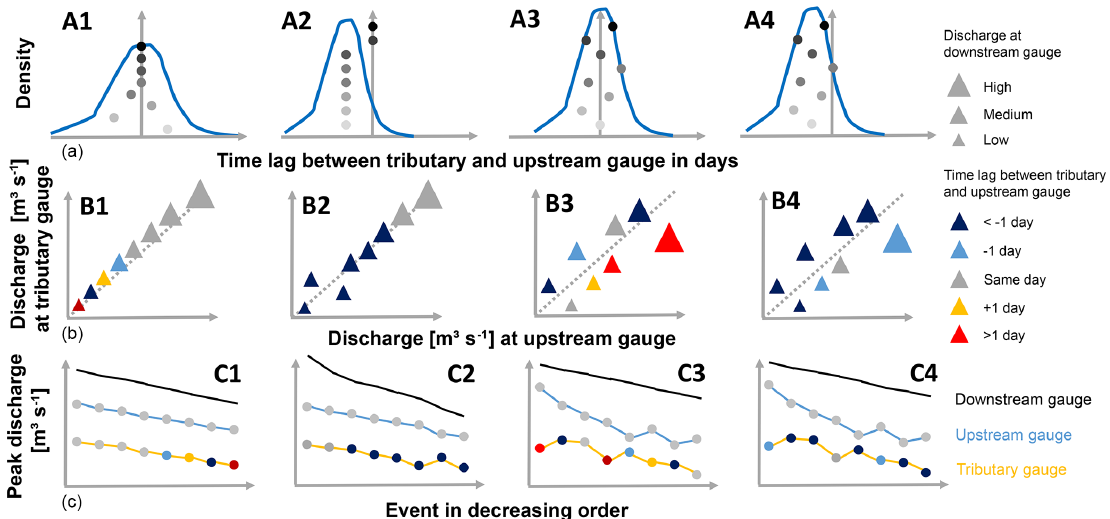
Figure 4. Flowchart of the analysis steps. In each column, the same flood event situation is presented. (a) Time lags in days between the tributary and upstream peaks as density plots of time lags for all events and for the largest flood peaks (shown using shaded dots in descending order). The distance between the shaded dots is identical and represents the ranks and not the differences in peak magnitude. (b) Representation of flood event discharges at triple points, with the colours corresponding to time lag. The grey symbols in (b) and (c) correspond to zero lag; the blue symbols represent an earlier tributary peak occurrence, and the red symbols represent a later peak occurrence. The symbol size indicates the flood magnitude at the downstream gauge. The diagonal line indicates the same specific discharge for the upstream and tributary peaks. A triangle above (below) the diagonal line indicates a higher (lower) specific discharge at the tributary compared with the upstream gauge. (c) The representation of peak flows at the downstream, upstream and tributary gauges, with the respective coloured points corresponding to the time lag of the peaks of the upstream and tributary gauges with respect to the downstream gauge. The flood peaks are ordered by the peak magnitude at the downstream gauge in descending